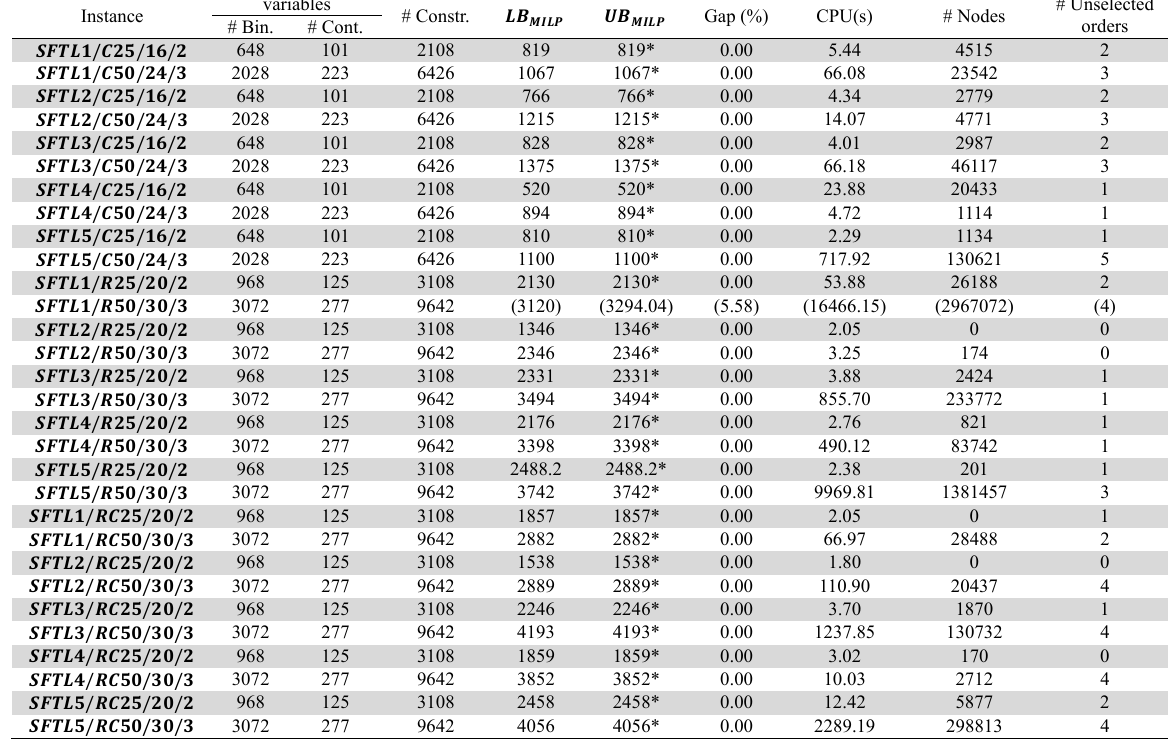
Table 6 Computational results for 30 generated